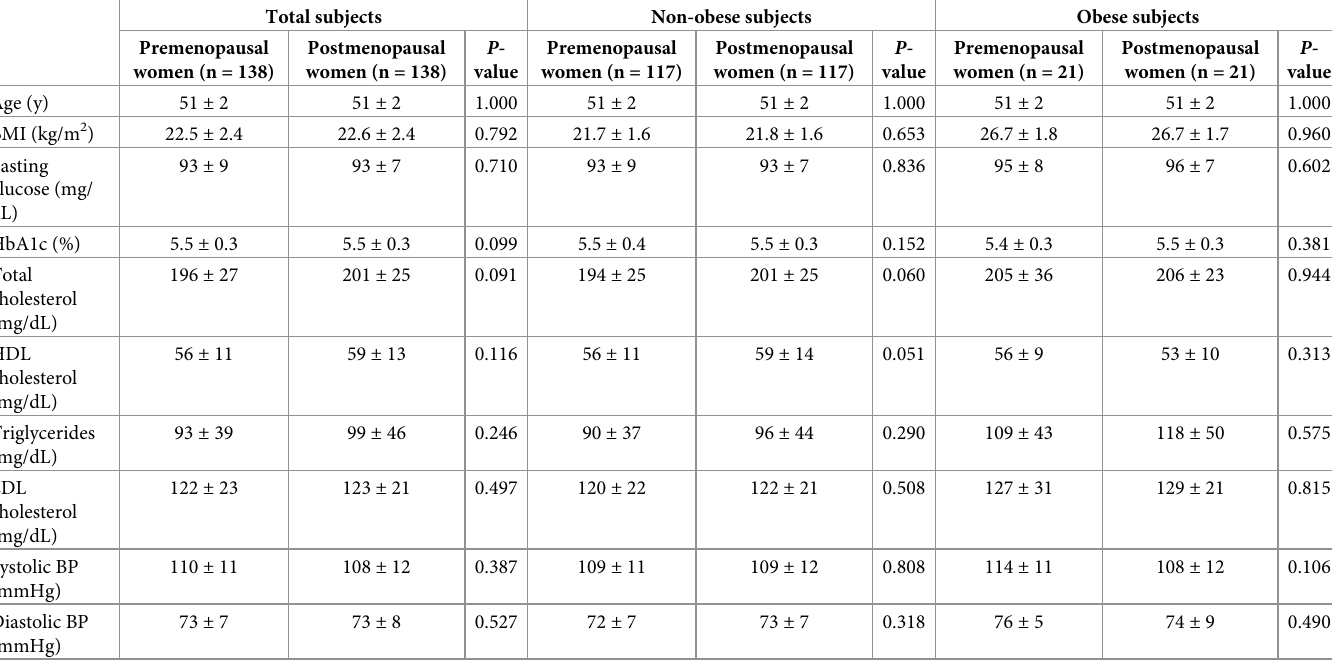
Table 3. Comparison of characteristics and cardiovascular risk factors in age- and BMI-matched